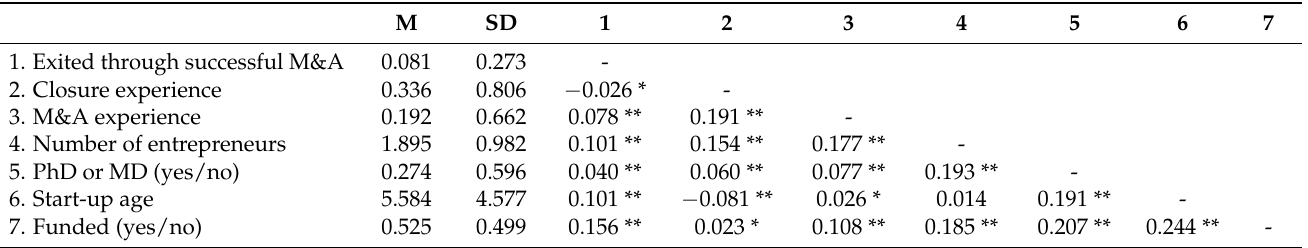
Table 1. Means, standard deviations, and correlation matrix of main variables.